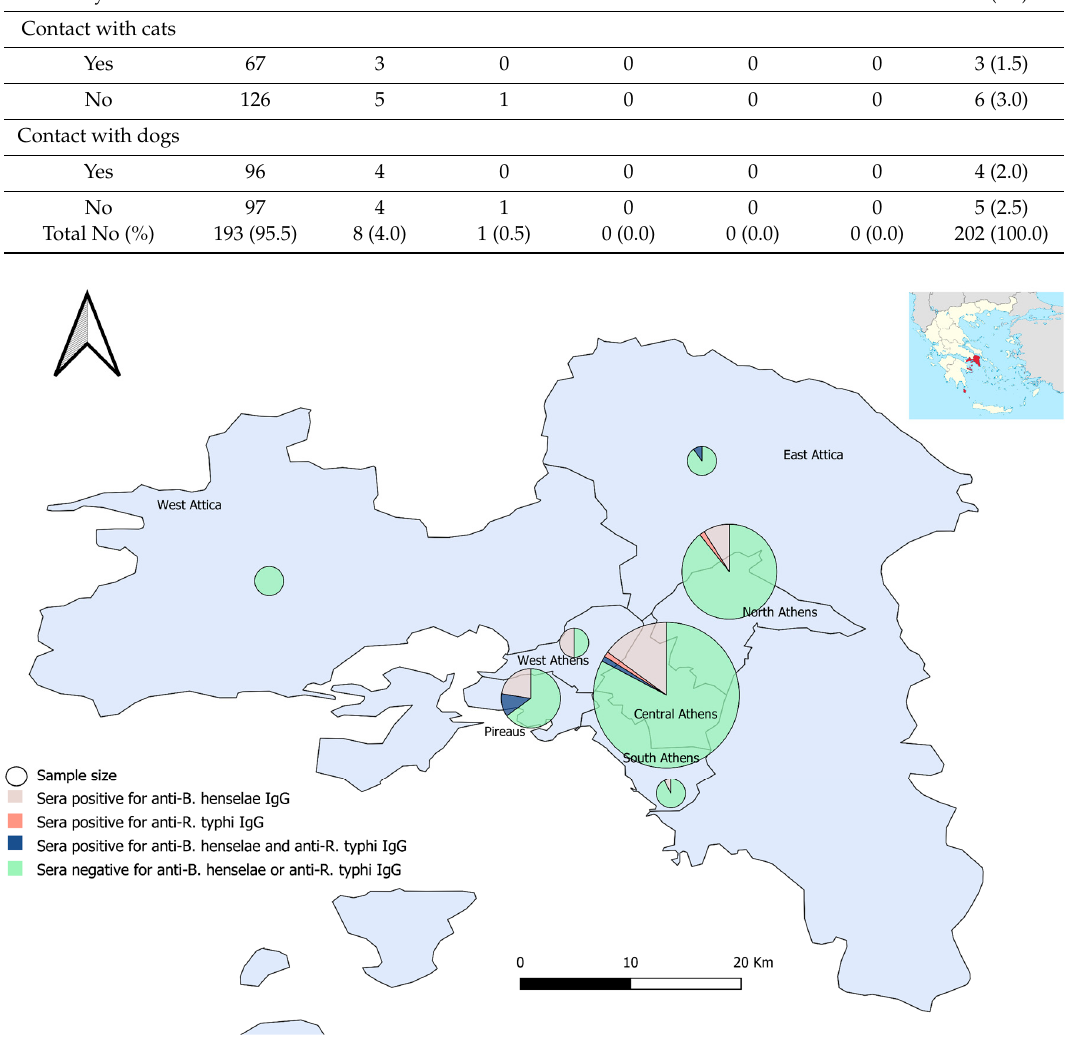
Figure 1. Sera sampling (size proportionate circles) and seropositivity percentages for anti- B. henselae and anti- R. typhi IgG antibodies, per Regional Unit, Attica, Greece.